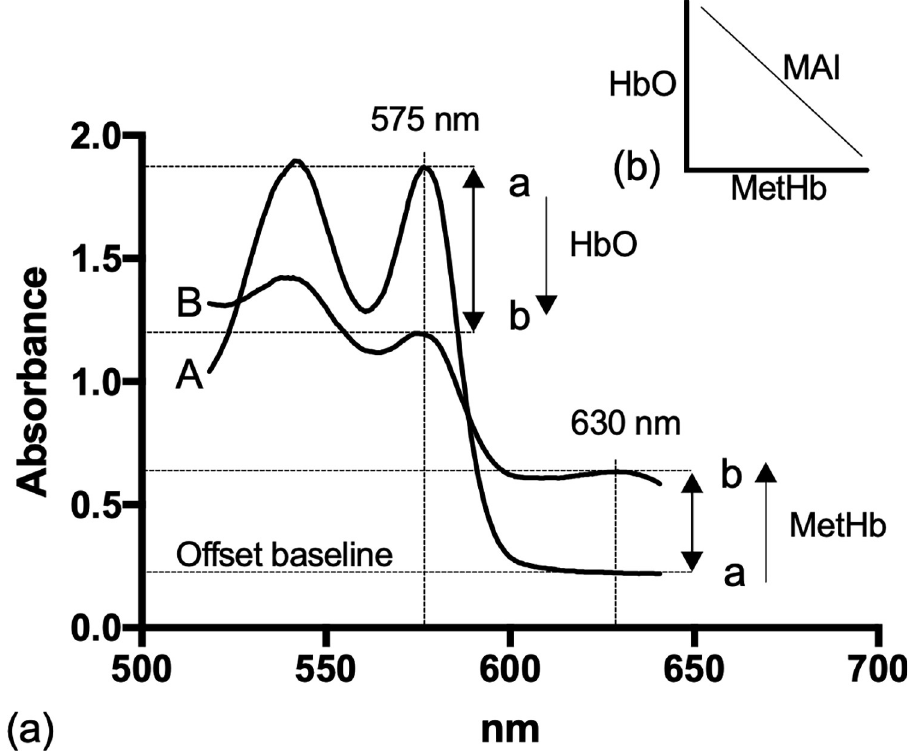
Fig 2. ( a) Absorbance spectra of duck blood (A) prior to an oral dose of PAPP and (B) 180 minutes after receiving 74.2 mg kg -1 of PAPP. The methaemoglobinaemia absorbance index (MAI) was based on dose-dependent increases in MetHb [a ! b] measured at 630 nm that was inversely correlated with dose-dependent declines in HbO measured at 575 nm [a ! b]. (b) The MAI was selected to be a highly linear continuous variable describing the severity of